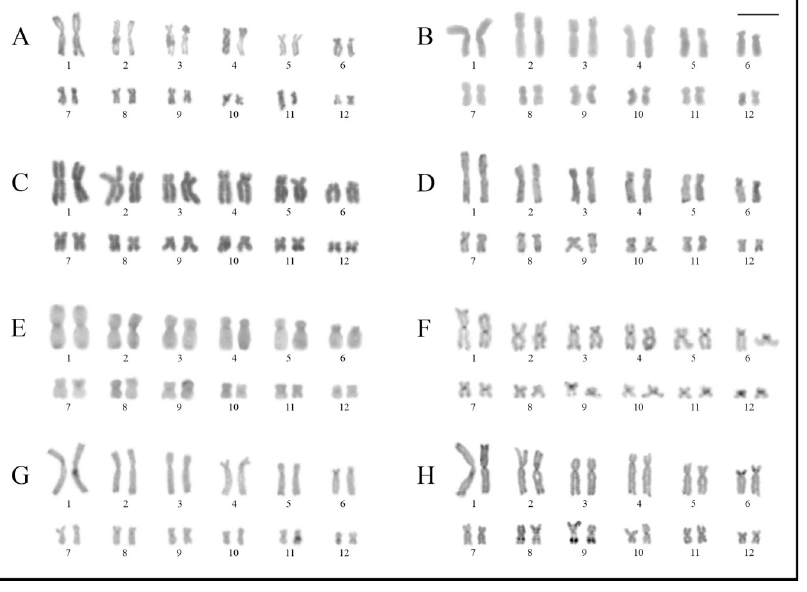
Fig 9. C-banded karyotypes of Trachycephalus , Itapotihyla , Osteopilus , and Dryaderces . A. Trachycephalus jordani . B. T . dibernardoi . C. T . helioi . D. T . typhonius . E. Itapotihyla langsdorffii . F. Osteopilus septentrionalis . G. Os . vastus . H. Dryaderces pearsoni